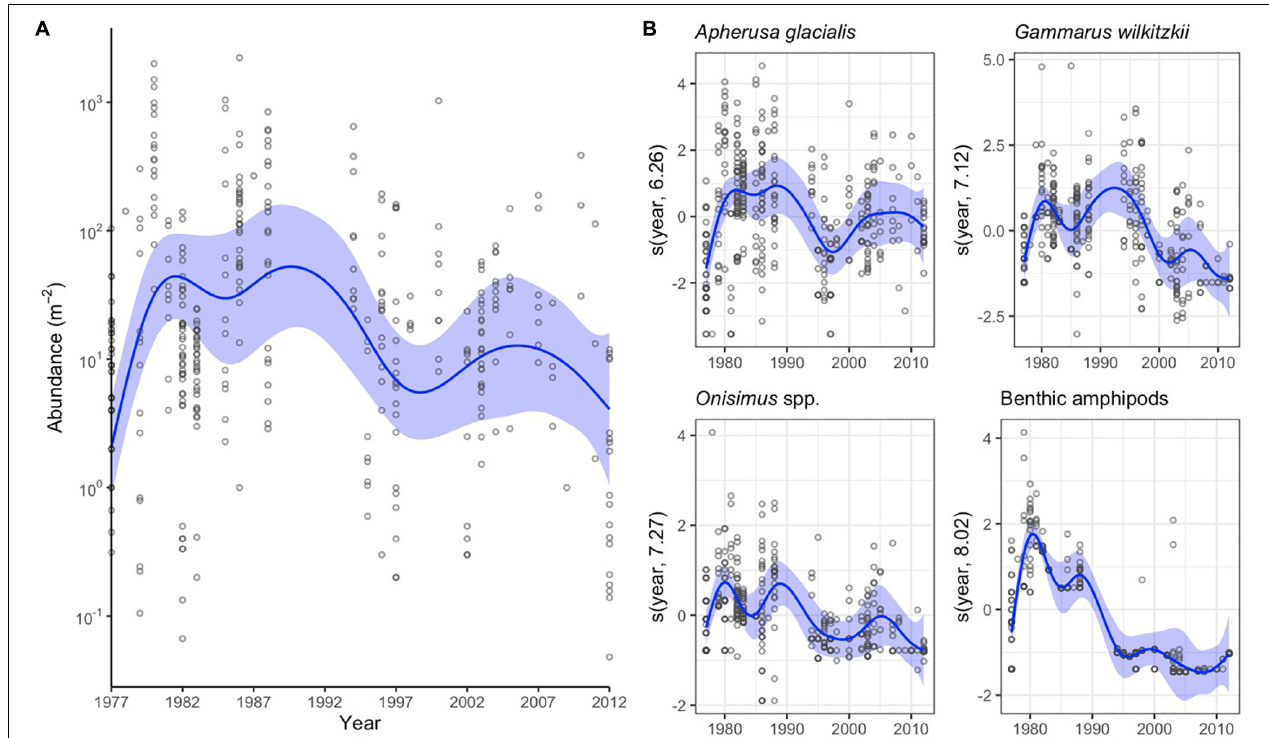
FIGURE 4 | Annual changes in sympagic crustacean abundance as indicated by the general additive mixed models (GAMM). (A) Changes in total abundance of sympagic crustaceans (excluding benthic amphipods). Blue line indicates the GAMM model, blue shading the 95% confidence intervals and dots actual data. Note the logarithm scale on y -axis. (B) GAMM models for the abundance of four amphipod taxa. The values are presented as the centered covariate scale of the annual smoother. Dots indicate residuals.